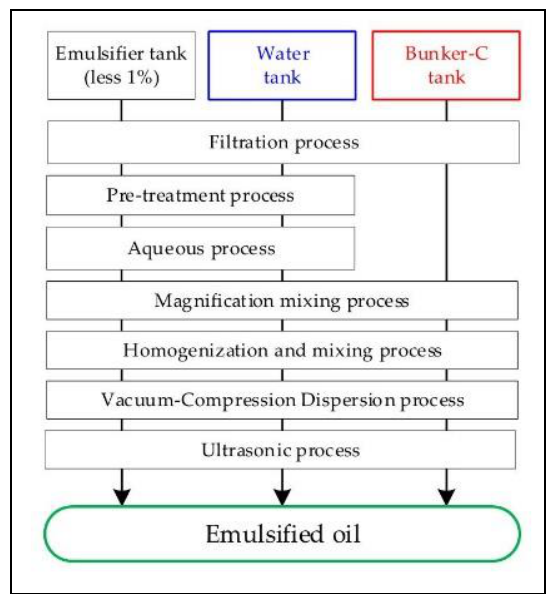
Figure 3. Seven-step production process.